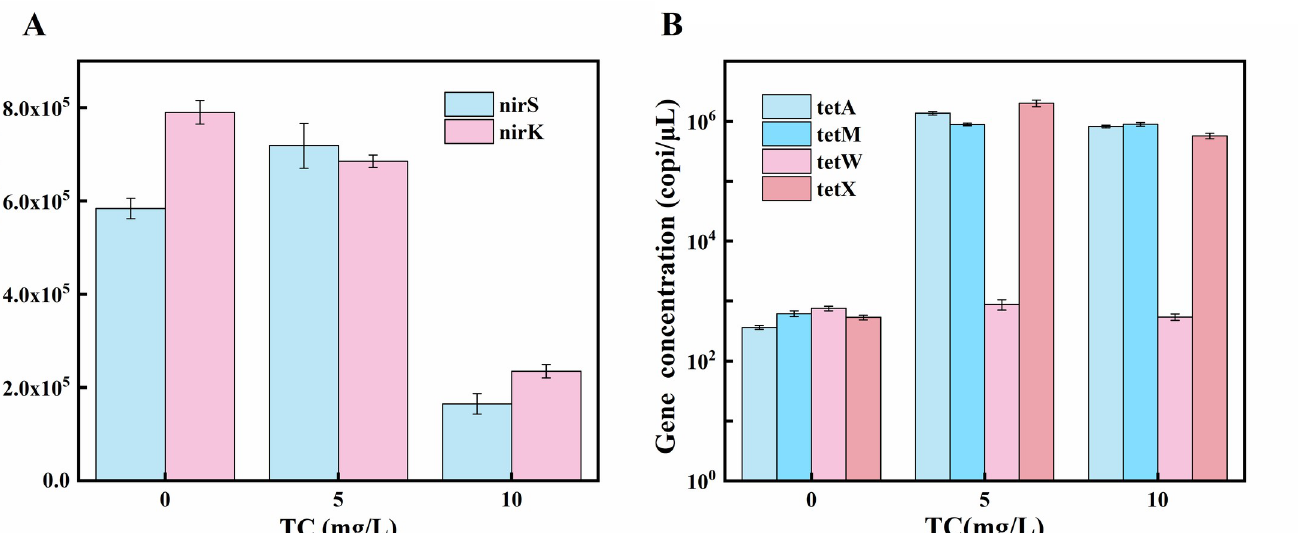
PLOS ONE | https://doi.org/10.1371/journal.pone.0261306 January 10,